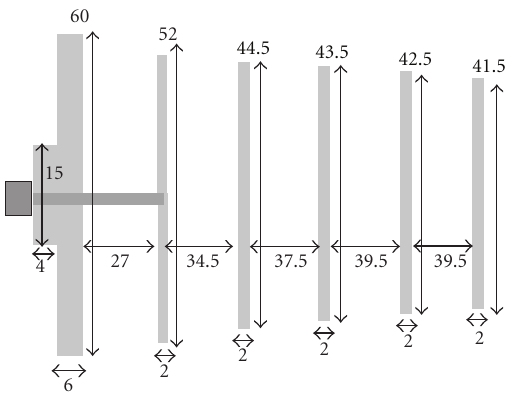
Figure 9: Geometry (in mm) of the printed dipole antenna with reflector and 4 directors.